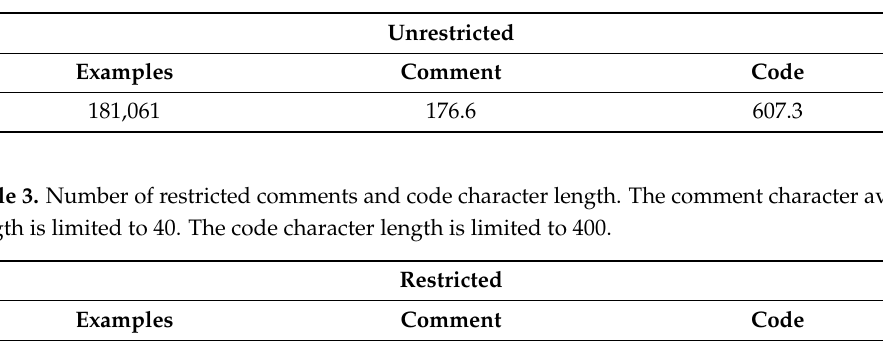
Table 2. Average length of count unrestricted comment and code character.